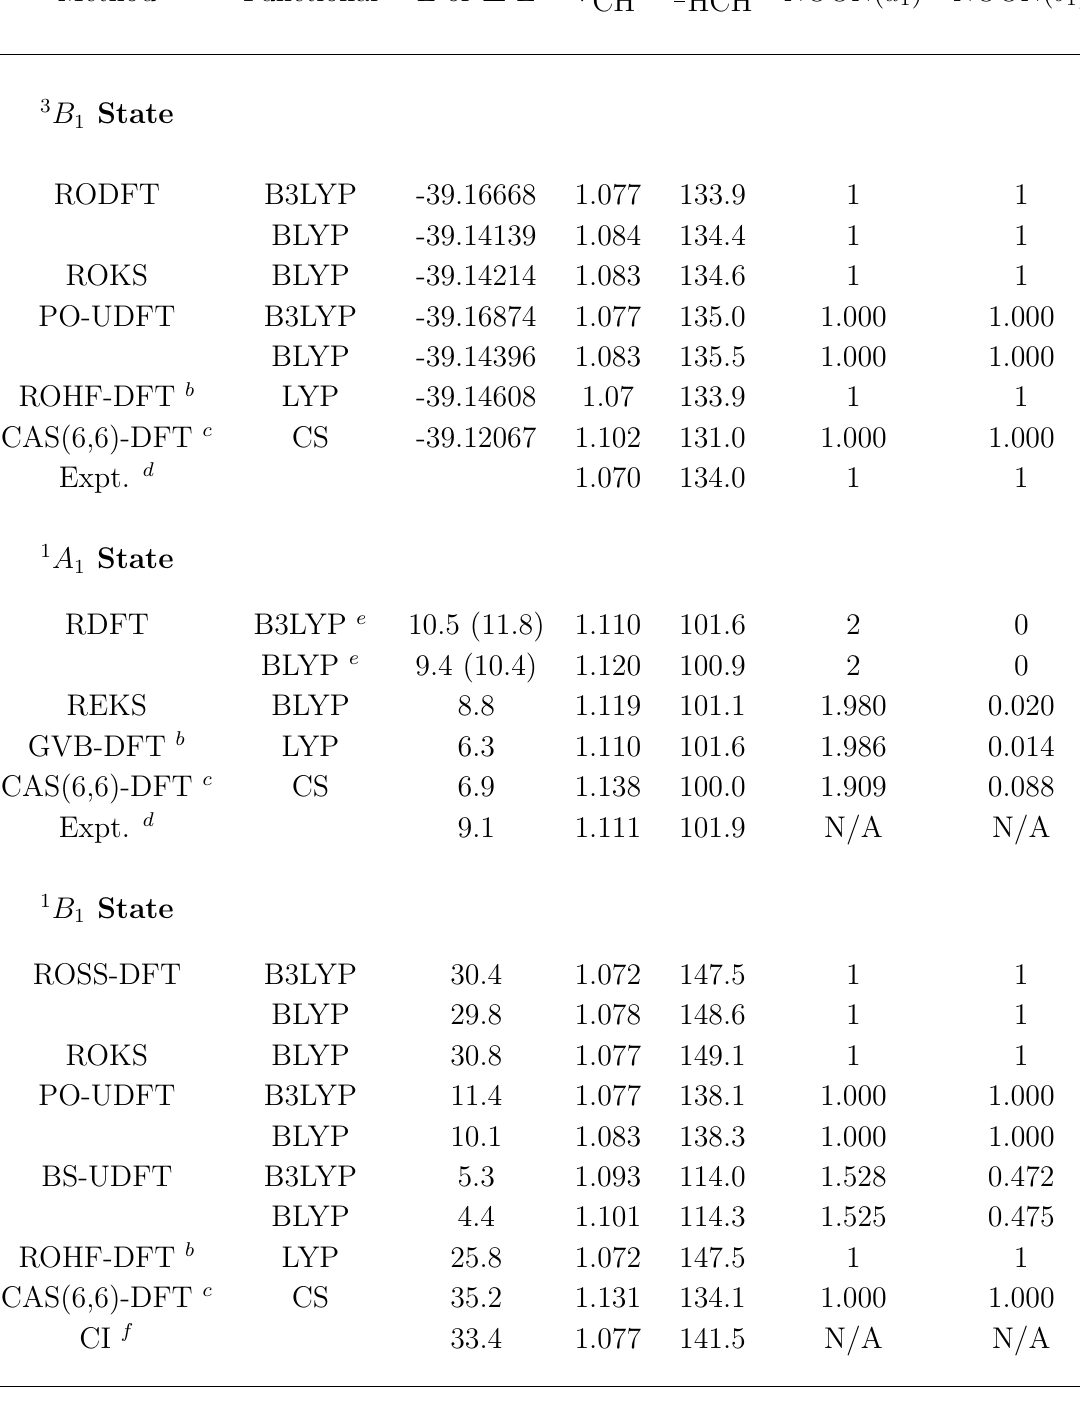
Table 1. Energies, geometries and NOON values for the three lowest states of methylene ( 1 ). a